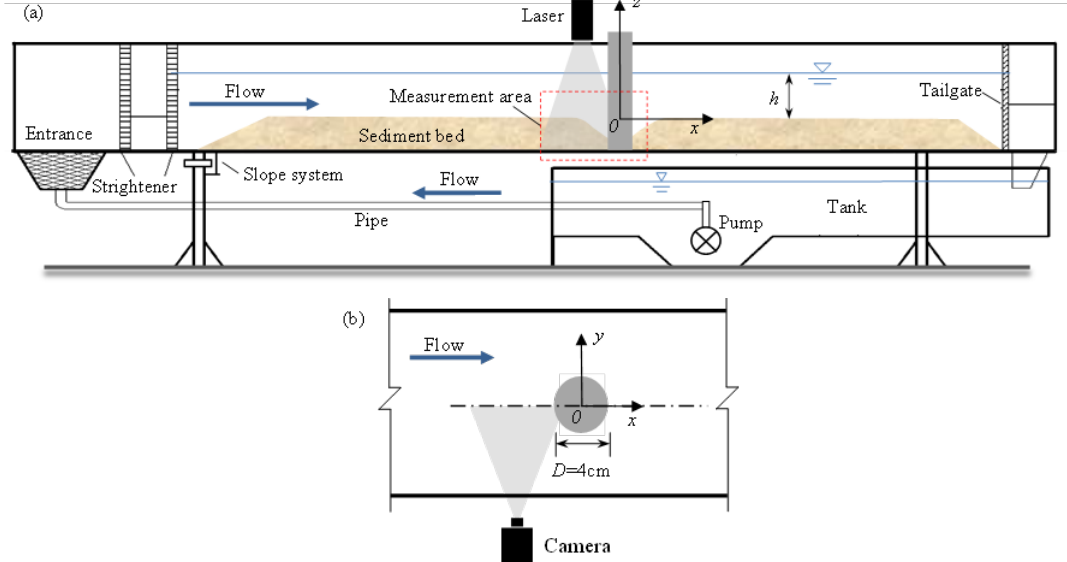
Figure 1. Experimental setup: ( a ) global side view; ( b ) local top view.